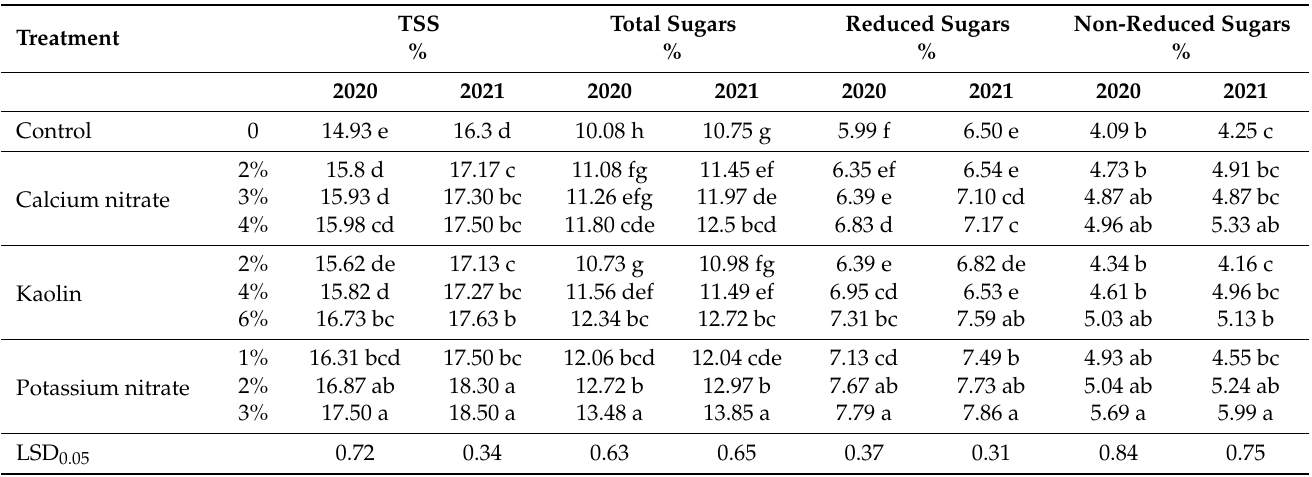
Table 6. The of the foliar application of potassium nitrate, calcium nitrate and kaolin on the fruit content from TSS %, and total reduced and non-reduced sugars of ‘Wonderful’ pomegranates during the 2020 and 2021